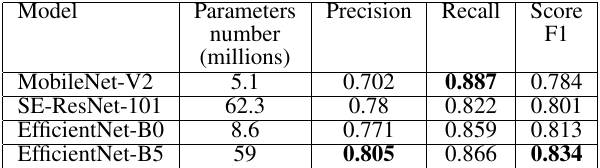
Table 1. Synthesis of building segmentation results